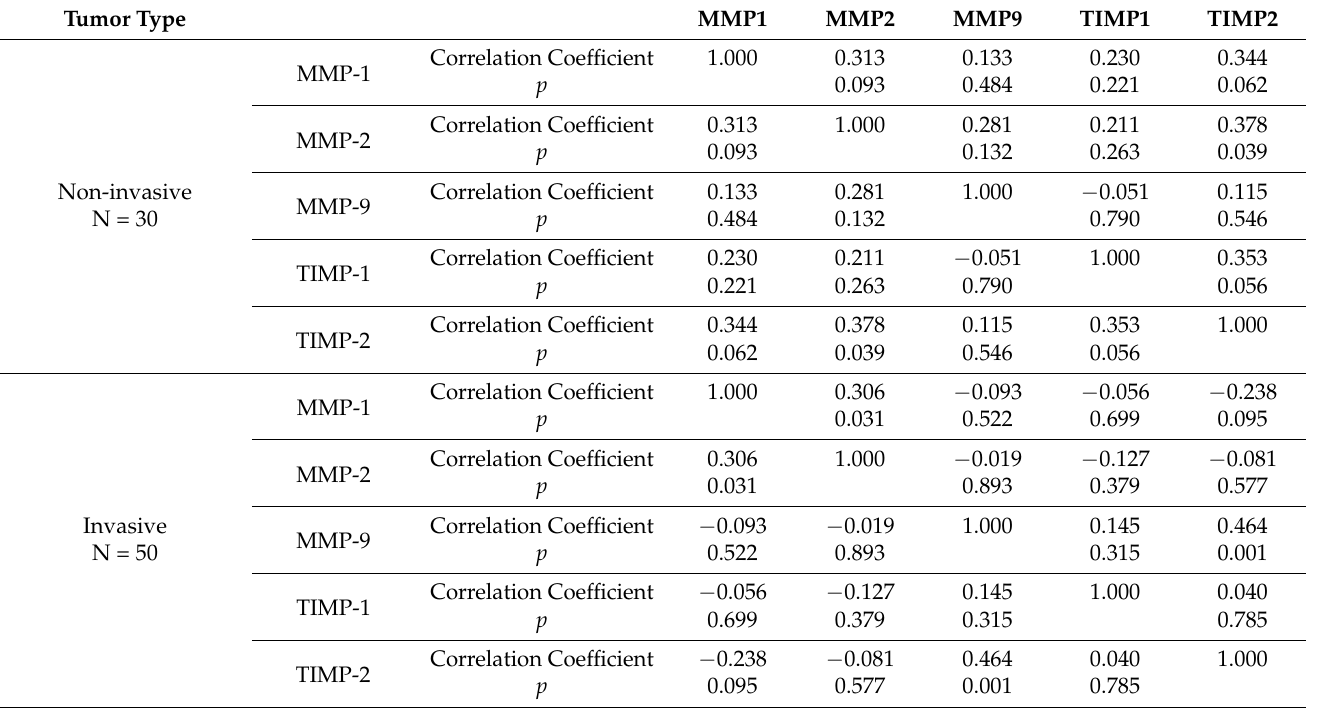
Table 4. Correlation between MMP-1, MMP-2, MMP-9, TIMP-1, and TIMP-2 expression in tumor tissue in non-invasive and invasive tumor types: Spearman correlation coefficients